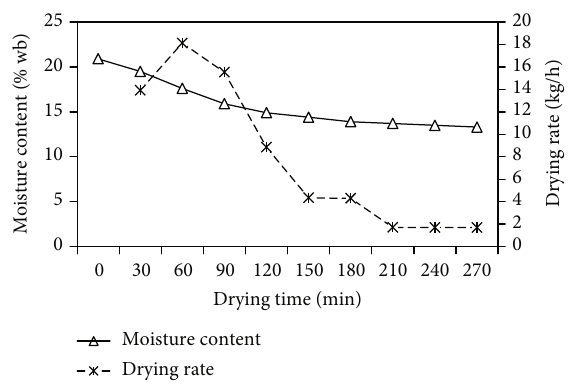
Figure 10: Variation of moisture content and drying rate with drying time.